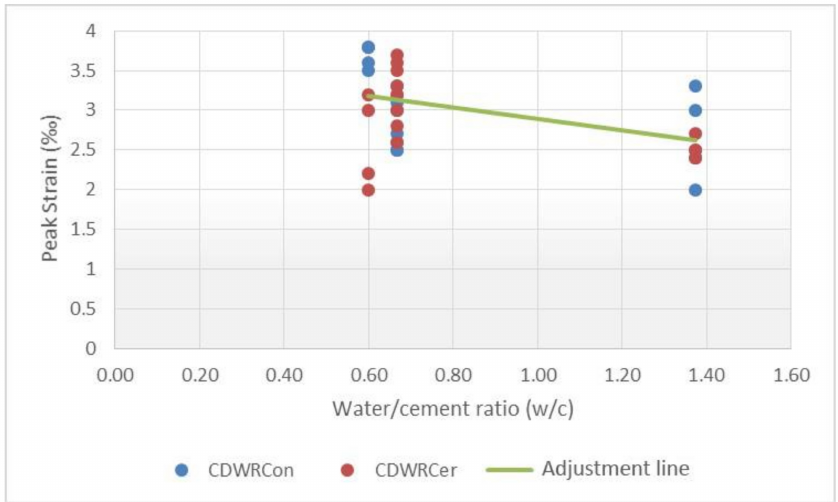
Figure 15. Relationship between water-cement ratio and peak